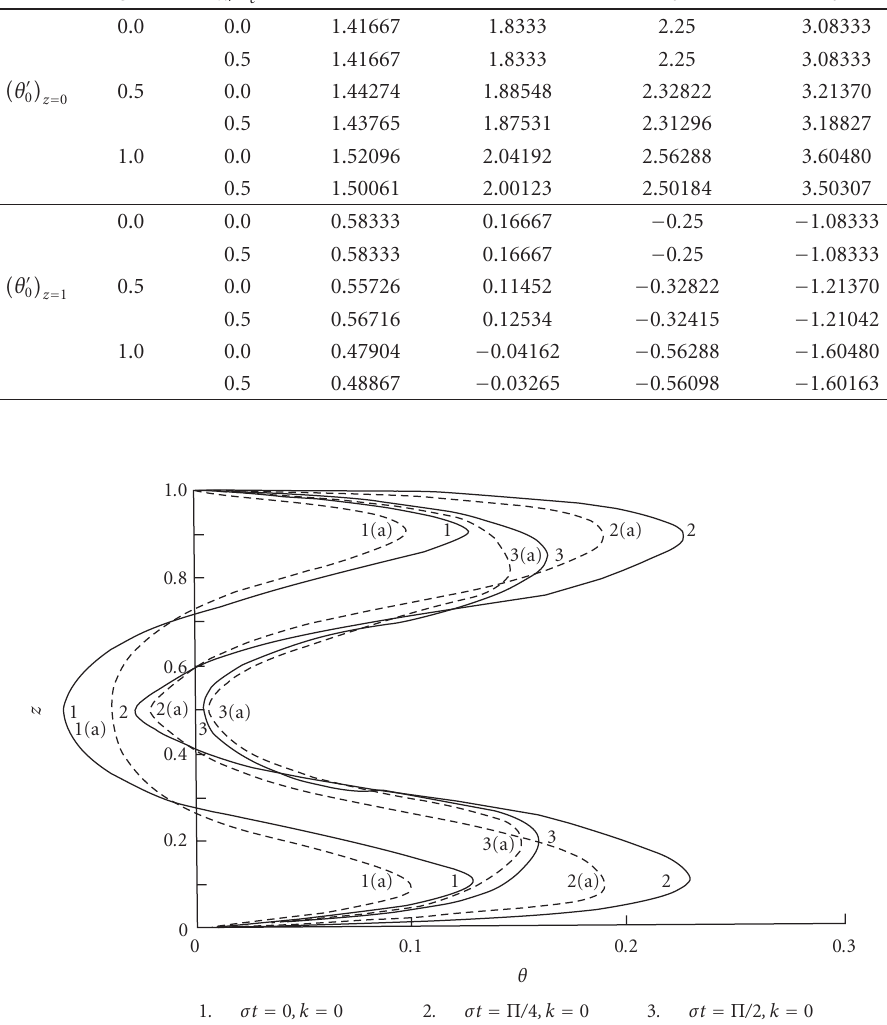
heat transfer at the colder wall and decrease the same at the hotter wall irrespective of the influences of other flow parameters. This phenomenon is evident from the results (5.1) and